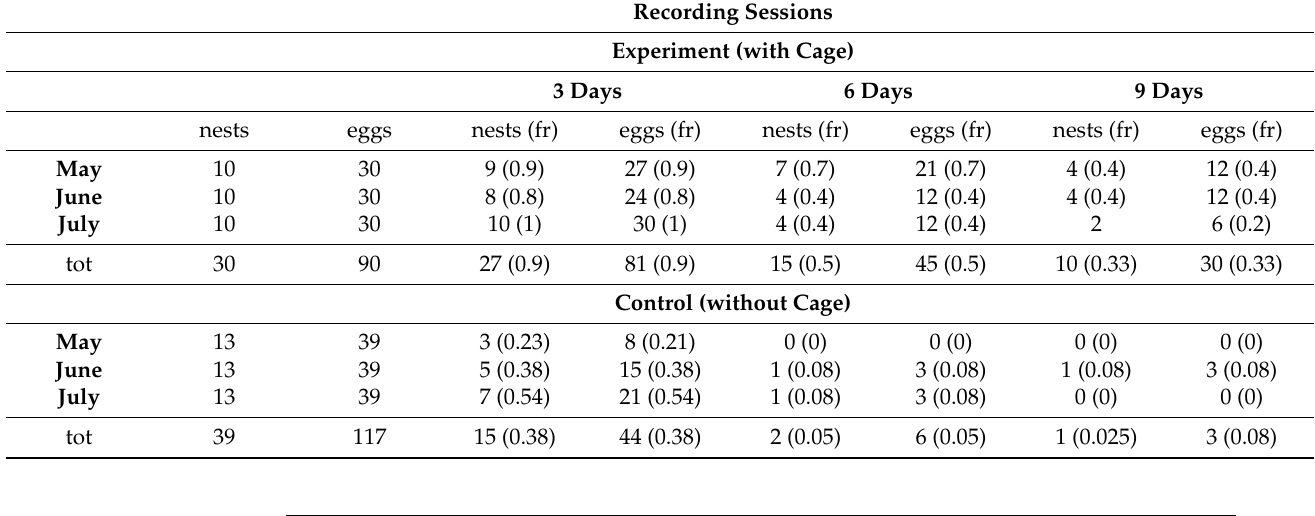
Table 1. Number and relative frequency (fr) of remnant nests and eggs in experiments (with cage) and controls (without cage) during the recording sessions (three, six, and nine days) in the three sub-seasonal sessions (May, June, and July).